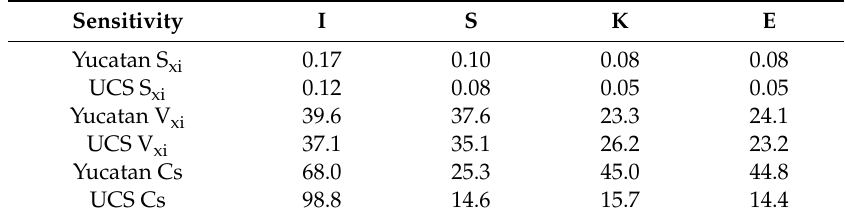
Table 5. Average sensitivity values for the Yucatan case and all possible combination scenarios for the ISKE method without the R parameter.